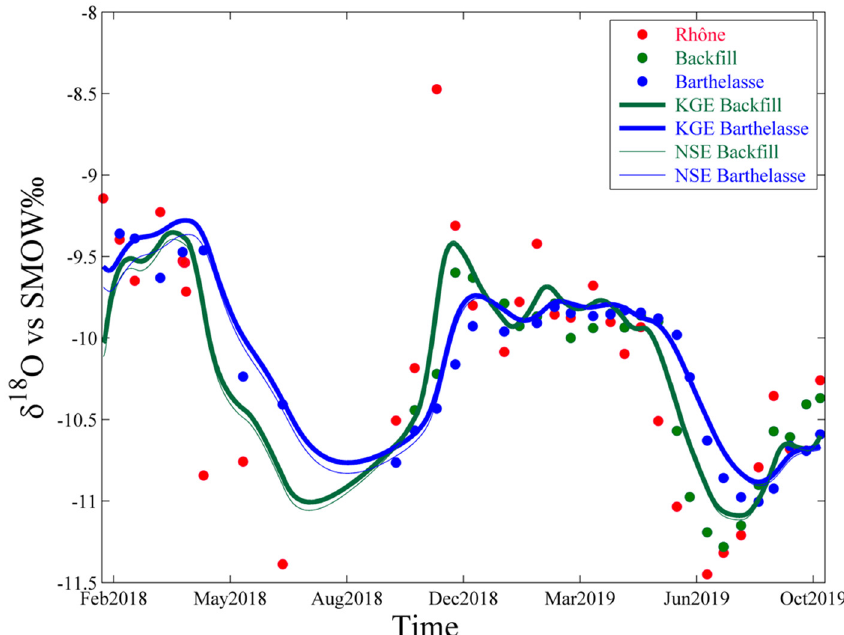
Figure 8. δ 18 O evolution in the Rhône, backfill and Barthelasse during the year 2018–2019, and the reconstitution of δ 18 O data following the DM model calibration (points = field samples, curves = models).